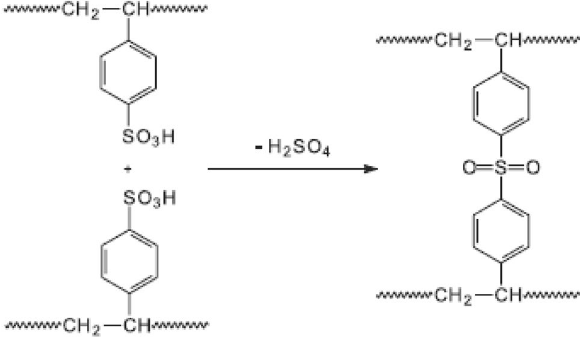
Figure 4. Crosslinking reaction of two sps